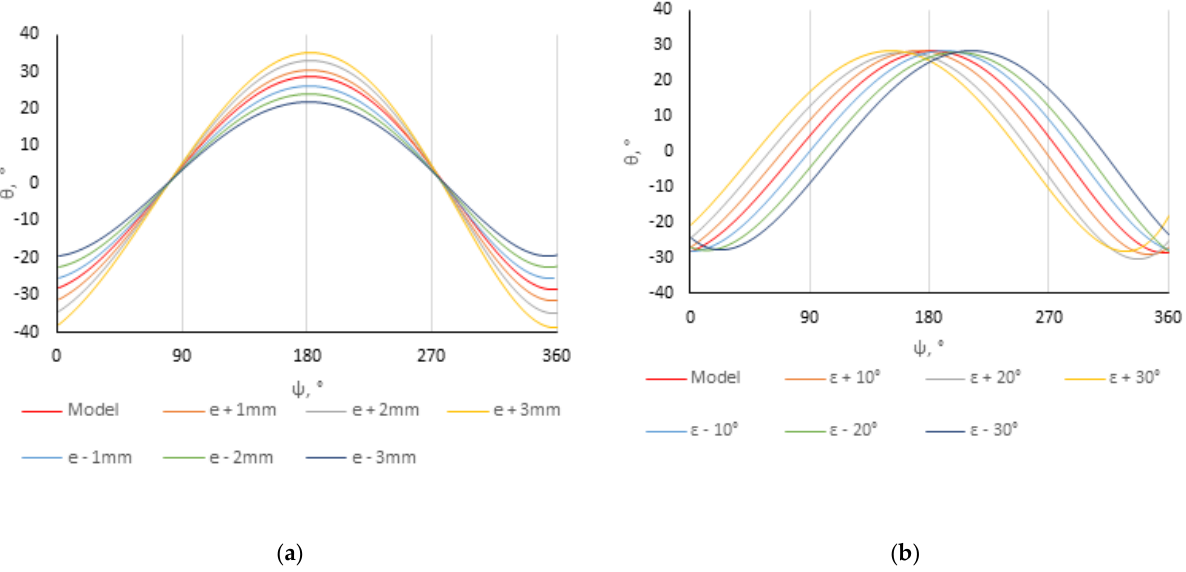
Figure 5. Influence of geometrical parameter to the function curve: ( a ) Influence of parameter e . ( b ) Influence of parameter ε .